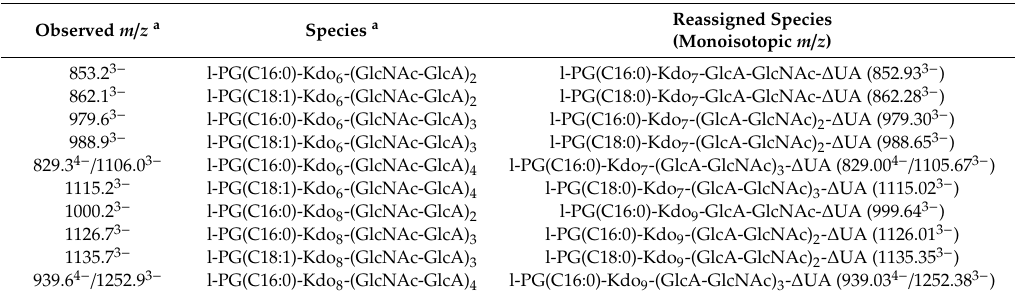
Table 1. Reassigning of ions in the LC-MS spectra for the terminal glycolipids of Escherichia coli K5 from the publication of Willis and coworkers [7].